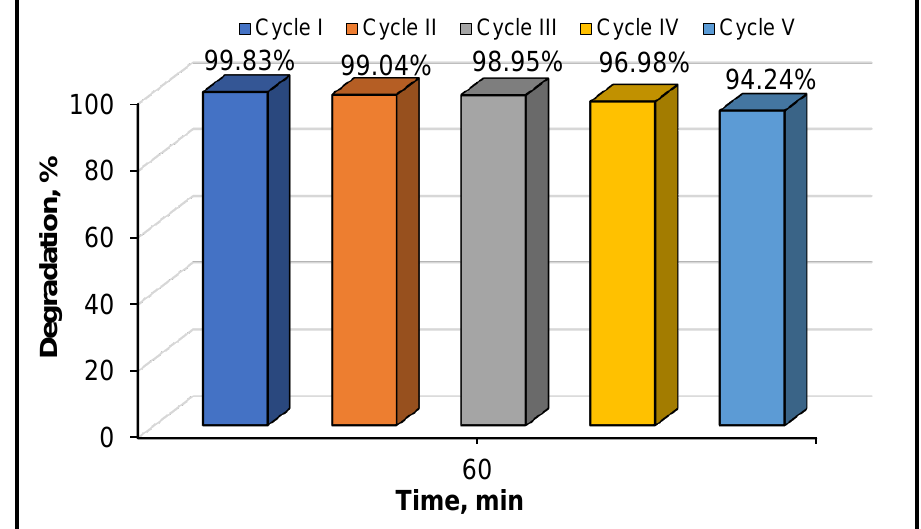
Figure 10. Photocatalytic degradation of CA by the E-750 system over five consecutive runs. CA = 10 mgL −1 , catalyst = 0.5 gL −1 and natural pH.